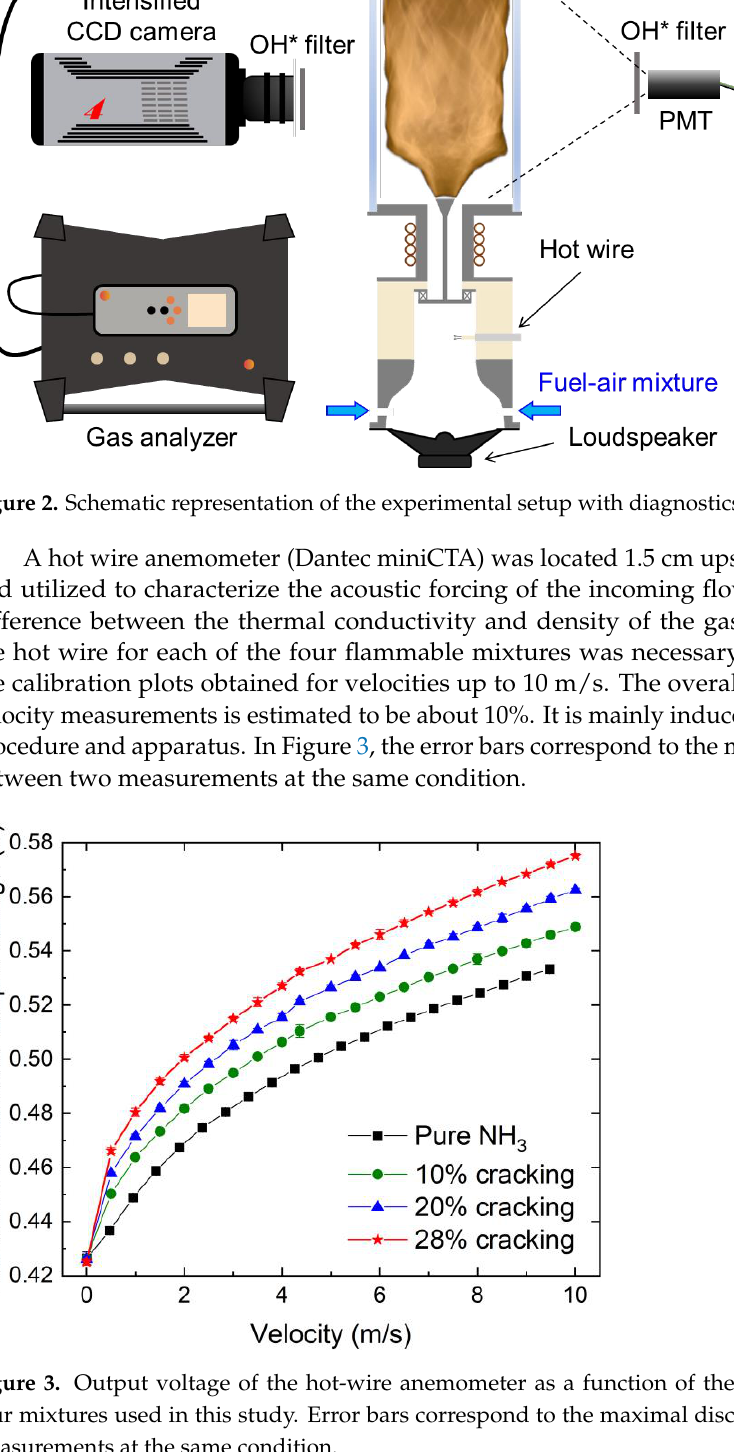
Figure 3. Output voltage of the hot-wire anemometer as a function of the flow velocity for the four mixtures used in this study. Error bars correspond to the maximal discrepancy between two measurements at the same condition.